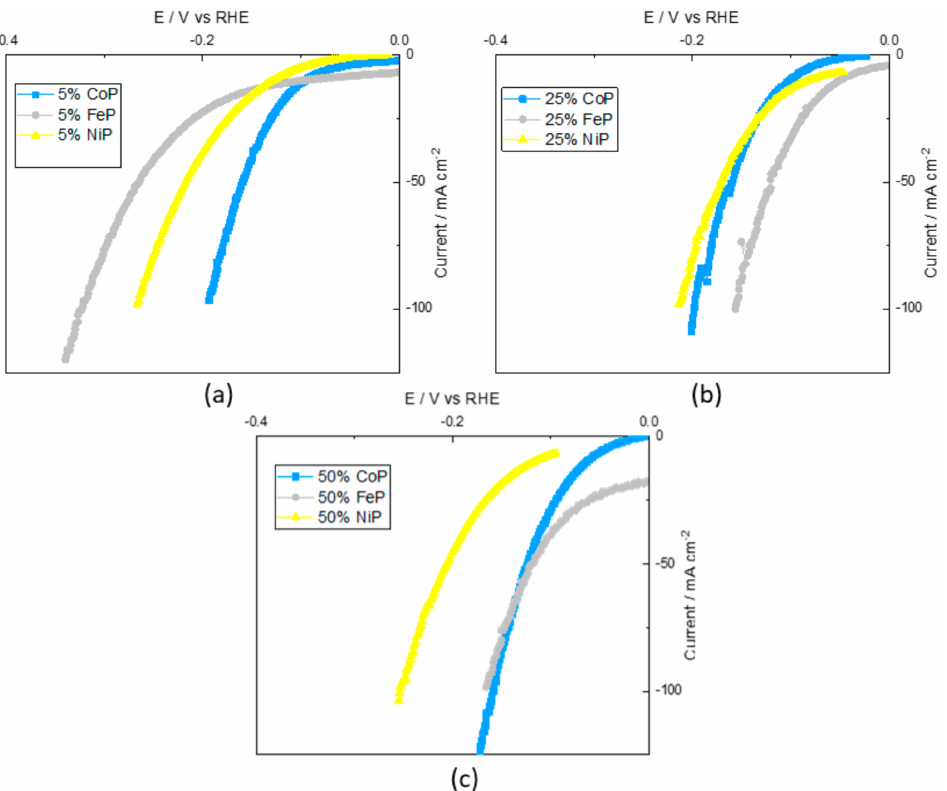
Figure 5. Cyclic voltammetry curves for the phosphorated ( a ) 5% metal, ( b ) 25% and ( c ) 50% metal content samples supported on